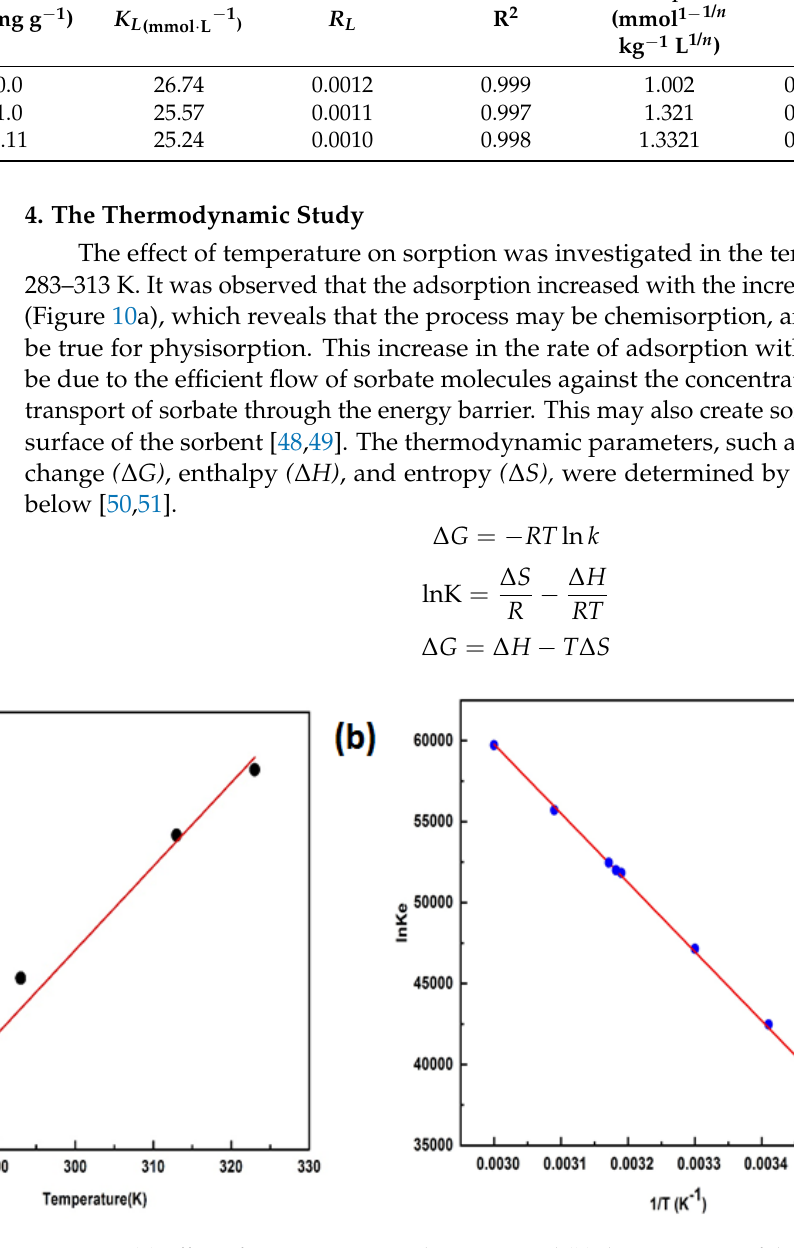
Figure 10. ( a ) Effect of temperature on adsorption, and ( b ) determination of thermodynamic parameters by the Van ’t Hoff equation. Table 3. Thermodynamic parameters of adsorption of Cd (II) ion onto AC.